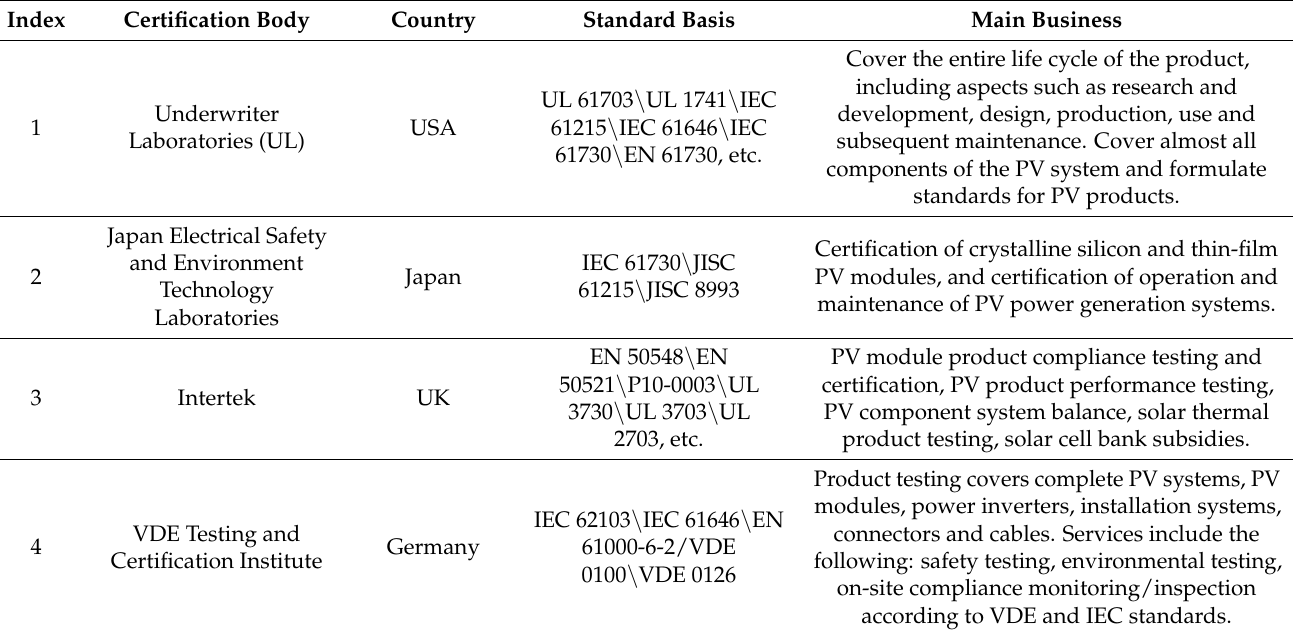
Table 1. Major PV certification